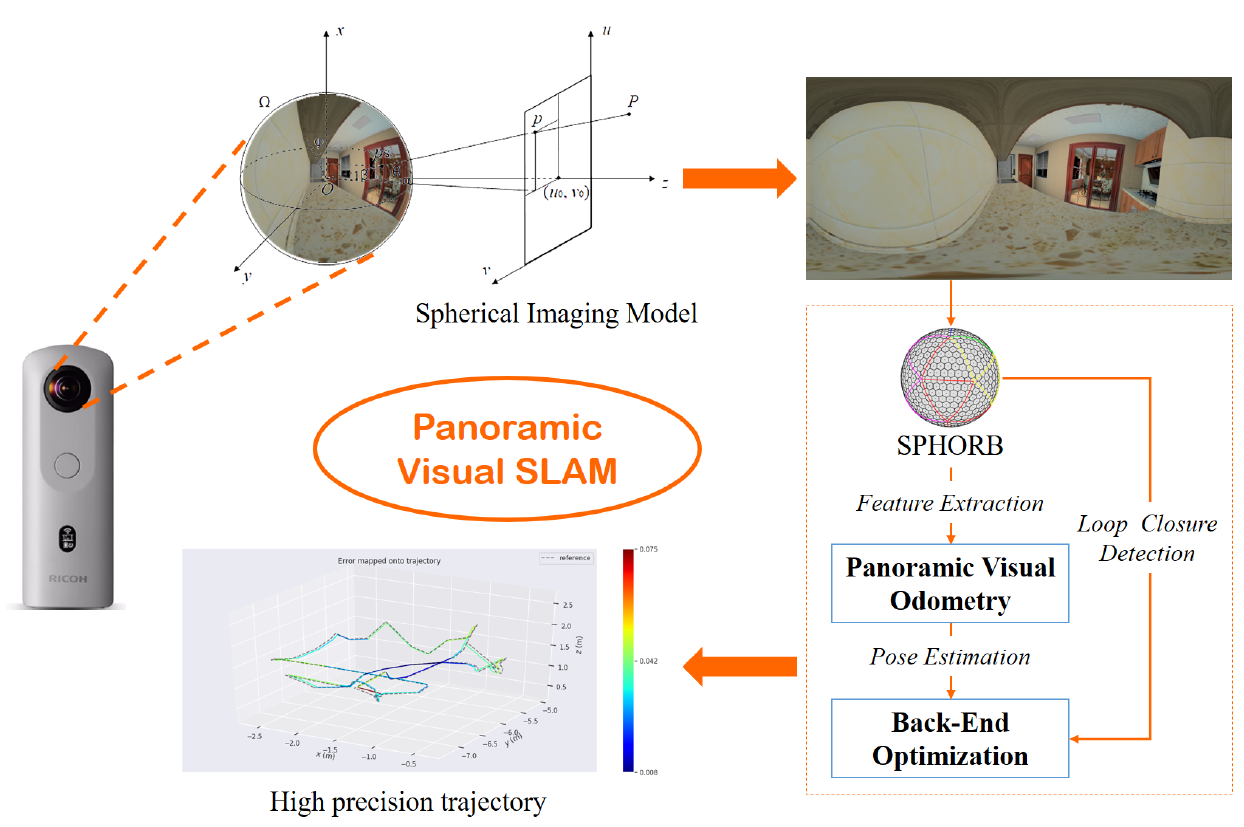
Figure 1. Flow chart of panoramic visual Simultaneous Localization and Mapping